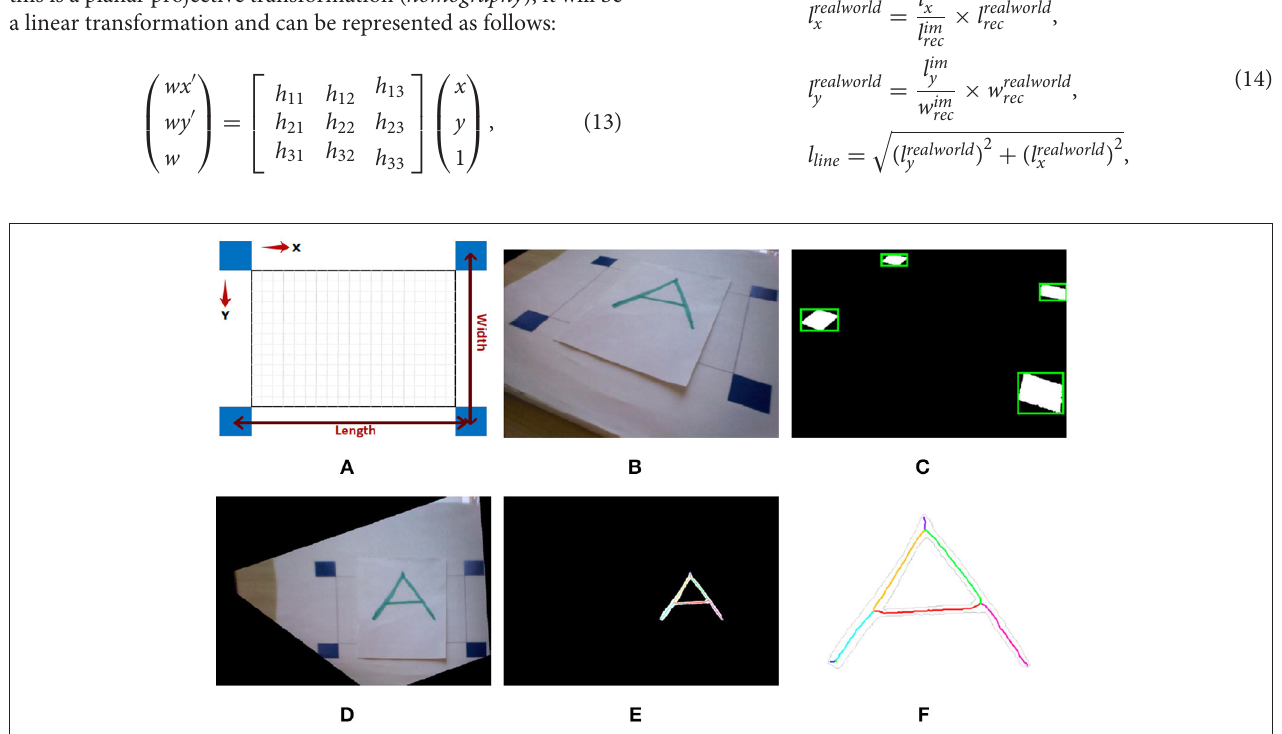
FIGURE 7 | Result of image processing, transformation and line segmentation. (A) Depicts the reference source which is printed on a paper and is placed in front of the camera, where all the 4 blue rectangles are inside the camera view. (B) Is the caputred image by NAO’s bottom camera. (C) Shows the result of image processing to detect the 4 blue corners necessary for the image transformation (Homography). Having the coordinates of the 4 blue corners creating an irregular quadrilateral, the captured image can be projected to a plane where these corners create a rectangle, whose result is shown in (D) . (E,F) are the results of image processing and line segmentation after